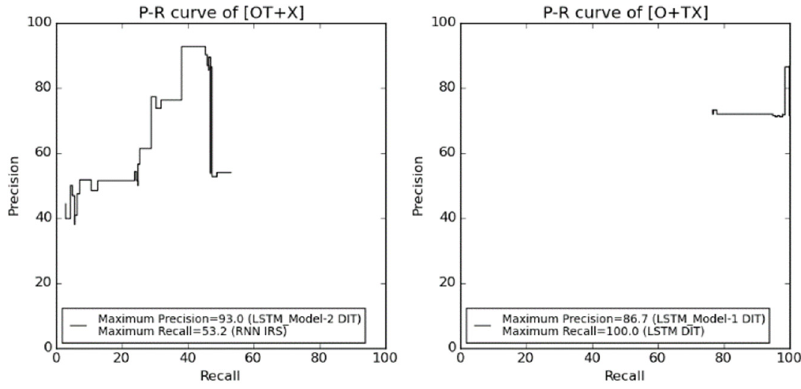
Figure 10. P–R curve of binary classification evaluation results (OT + X) and (O + TX).